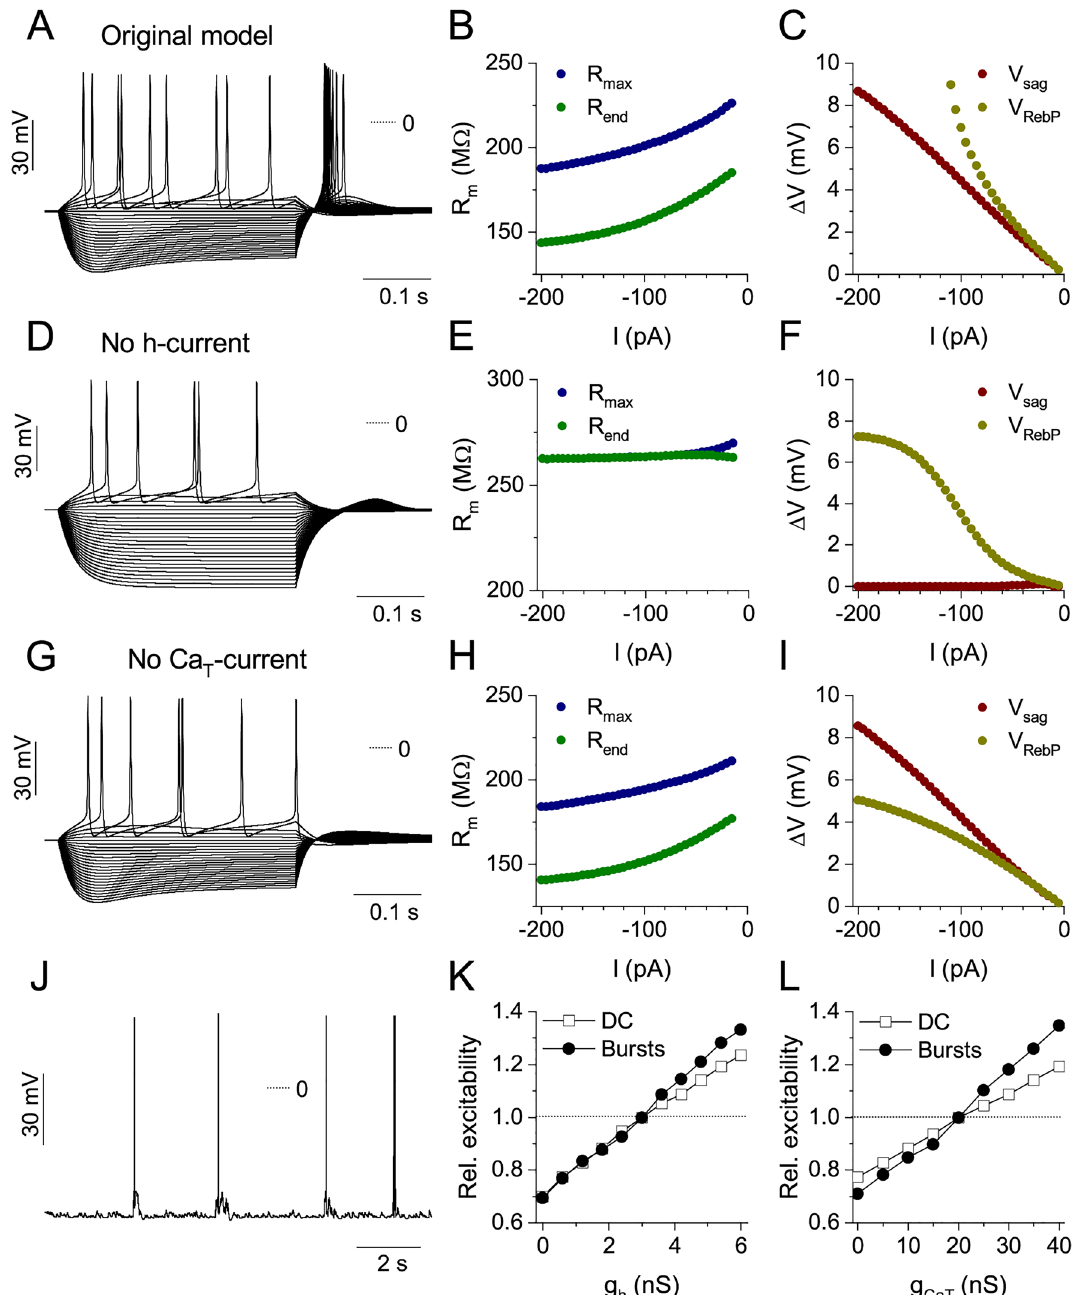
Figure 8. The computational model reproduces the physiological effects of h- and T-currents and the homeostatic changes observed under activity-deprivation. ( A ) shows the voltage responses of the generic model neuron expressing moderate levels of intrinsic h- and T-currents while ( D , G ) show the responses after selectively removing the h- or T-current, respectively. Panels ( B , E , H ) demonstrate the membrane resistance plotted against the injected current for the three conditions while ( C , F , I ) display voltage sag and rebound potential relationships from the same data. RebP increases steeply at current levels more negative than − 60 pA in the generic model ( C ). Moderate RebP is still observed when the T-current alone is removed ( I ). Firing output of the model is shown when network bursting type synaptic input is used ( J ). Relative cumulative spike numbers are plotted against the maximal conductance of the h- and T-currents (( K , L ), see